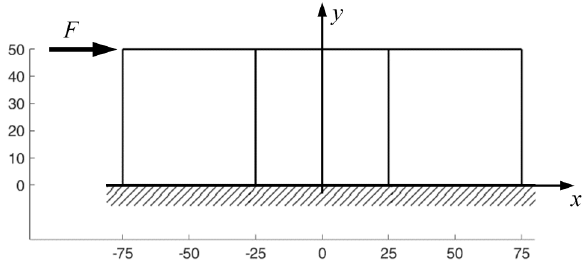
Figure 14. Geometry of a two-dimensional domain consisting of one row of three square elements (linear measurements in mm).